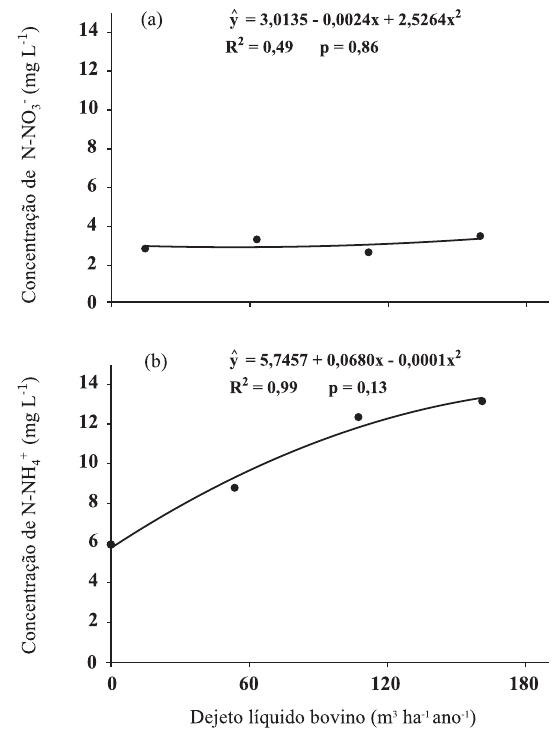
Figura 2. Concentrações médias ponderadas de